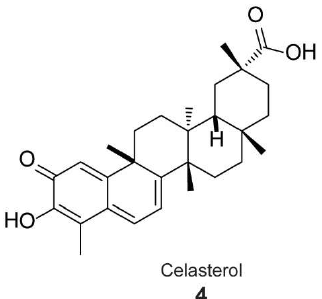
Figure 3. Chemical structure of celasterol.